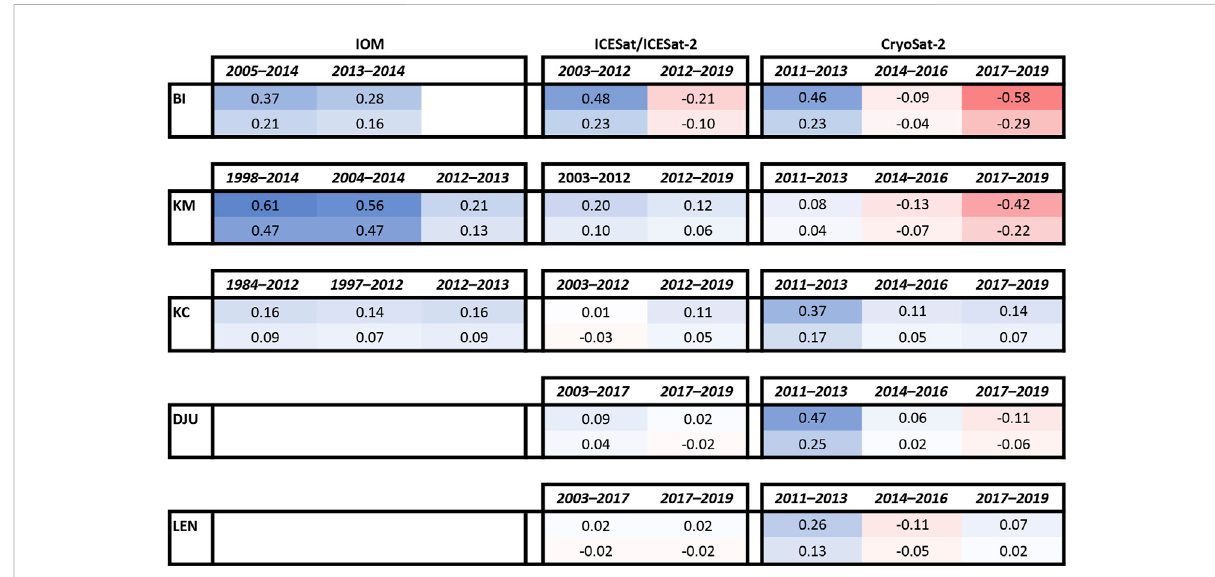
FIGURE 6 An overview diagram ofmassbalance estimates showing theirmaximumandminimum values for different time periods inunits ofm ieq a − 1 .The color used varies on a red-white-blue colormap varying from − 0.6 – 0.6 m ieq a − 1 . For values near zero we introduce a minimum error bound of 0.05 m ieq a − 1 . All values are rounded to 2 decimal